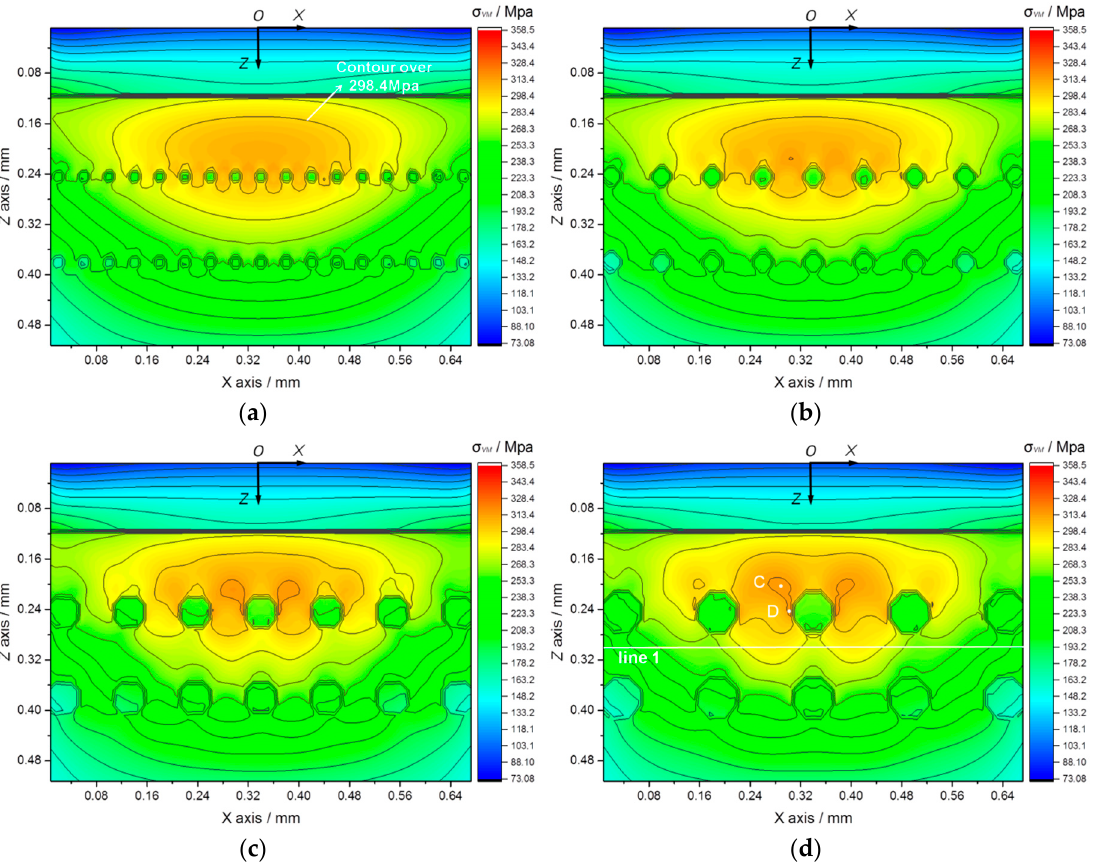
Figure 17. Von Mises stress fields in cross section XOZ with increasing fiber diameters: ( a ) 16 µ m, ( b ) 32 µ m, ( c ) 48 µ m, and ( d ) 64 µ m.